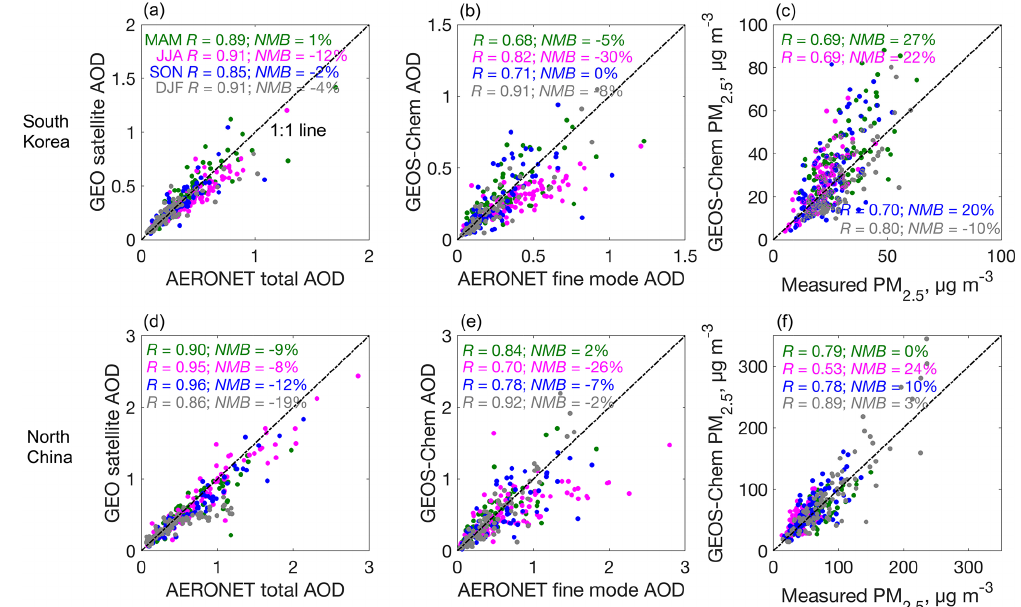
Figure 7. Scatterplots of regional mean daily (a, d) GEO satellite AOD vs. AERONET total AOD, (b, e) GEOS-Chem AOD vs. AERONET fine-model AOD, and (c, f) GEOS-Chem PM 2 . 5 vs. measured PM 2 . 5 over South Korea (a–c) and North China (d–f) . Different colors represent different seasons. Values inset are correlation coefficients ( R ) and normalized mean biases (NMBs) between surface measurements and GEO satellite or GEOS-Chem